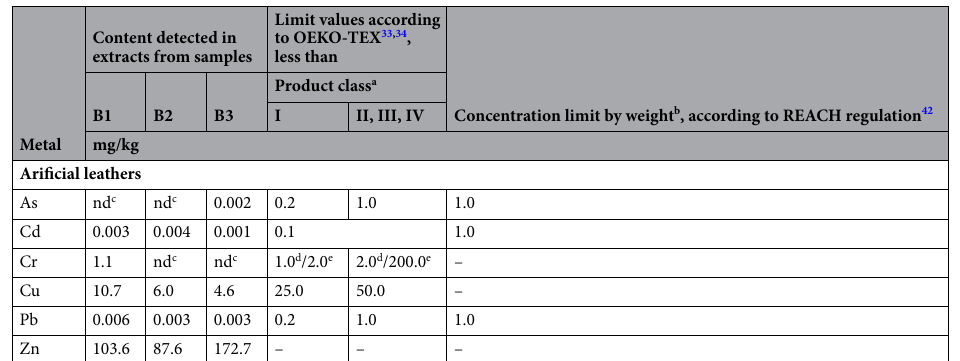
concerning the Registration, Evaluation, Authorisation and Restriction of Chemicals (REACH) 42 . This regula- tion was designed to ensure a high level of protection of both human health and the environment. It establishes rules concerning, among others, the manufacturing, placing on the market and use of substances in articles 42 . Analysis of metal contents in extracts from natural leathers. As suggested by the data presented in Table 2, the element present in the smallest amount in the extract obtained from sample A1 was Pb (0.004 mg/ kg). In the case of samples A2 and A3, no As was found at all, while the element detected in the smallest amounts was also Pb (0.005 mg/kg and 0.003 mg/kg, respectively). When taking into account the heavy metals analysed, all the extracts were characterised by the highest content of Cr (lining leathers—more than 401 mg/kg, upper leather—more than 228 mg/kg). Significantly lower contents of this metal in extracts obtained using artificial sweat from insole leathers (53.30 mg/kg) and upper leathers (67.18 mg/kg) were detected by ICP-AES by Basa- ran et al. 27 . They also determined a lower content of Zn in the samples (insole leathers—9.01 mg/kg, upper leathers—2.26 mg/kg). Turkish insole leathers contained less Cu (3.92 mg/kg) as compared with its content in the extracts from the tested samples of lining leathers A1—4.4 mg/kg and A2—6.1 mg/kg (Table 2). A similar pattern was observed for upper leather (Turkish leathers—2.14 mg/kg, sample A3—3.2 mg/kg). However, leath- ers for both inner and outer footwear components tested by Basaran et al. 27 contained more Cd (0.16 mg/kg and